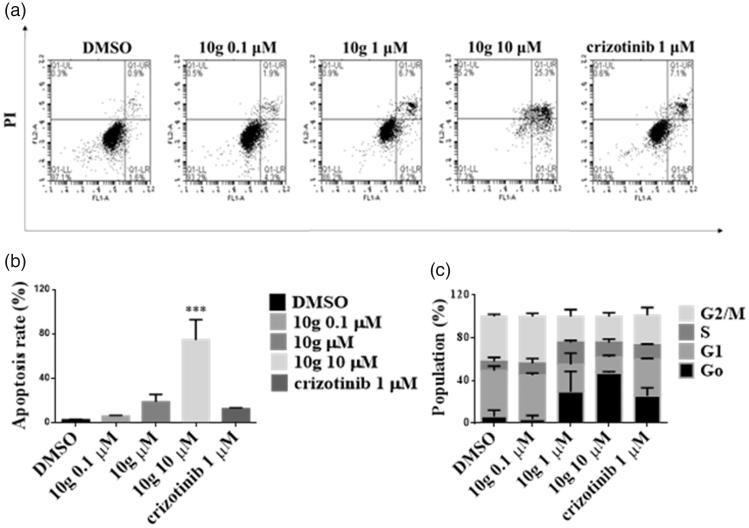
Effect on the cell apoptosis and cell cycle arrest in H2228 cells. (a, b) Percent of apoptotic cells detected by FACS analysis in H2228 cells. cells were harvested and incubated in a binding buffer containing propidium iodide and annexin V-FITC. t-test ***p < .005. (c) H2228 cells were incubated with indicated concentration of 10 g, fixed and stained with propidium iodide and analysed by using FACS.